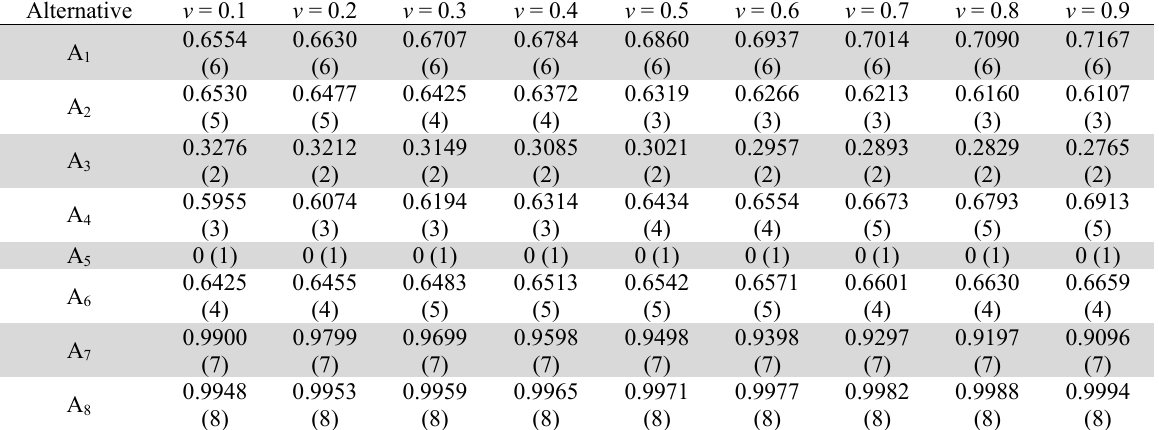
Changes in rankings with varying v values in VIKOR